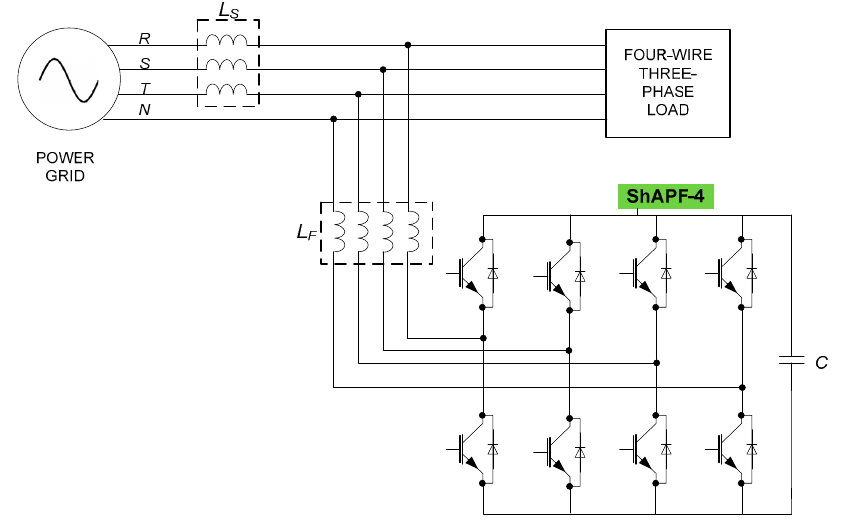
Figure 4. Four-leg ShAPF connected to a three-phase, four-wire system.